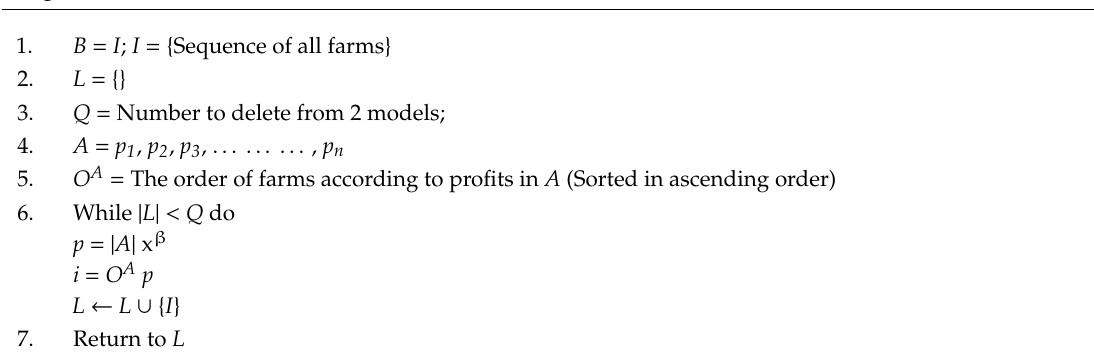
Algorithm 3: Worst Removal